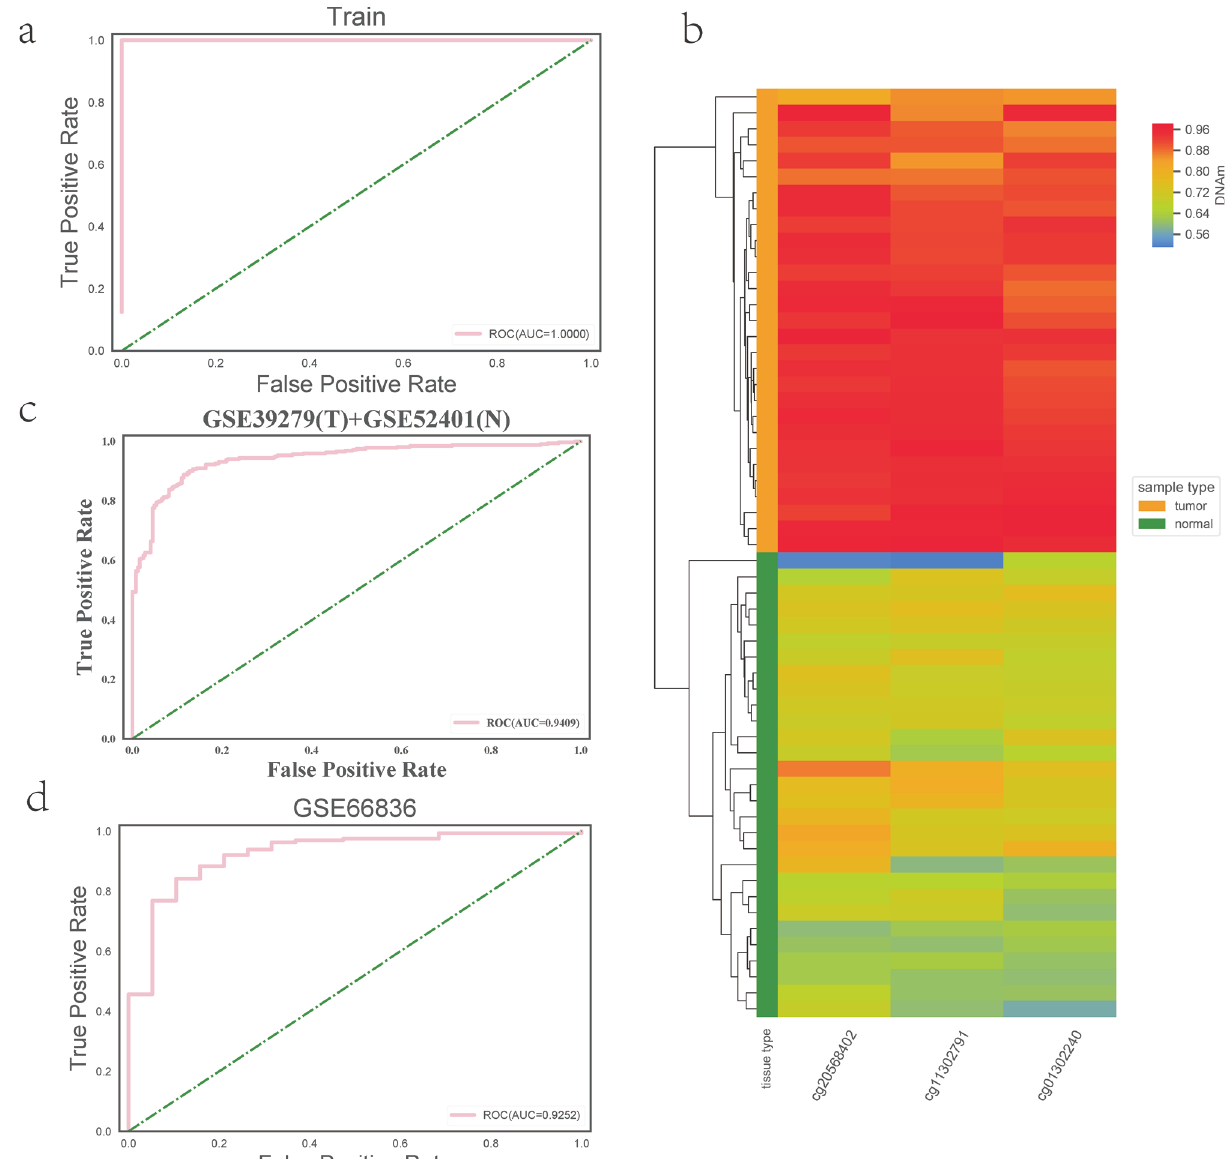
Figure 2 - Screening of methylation markers for lung adenocarcinoma and the construction and validation of the diagnostic classifier. (a) The ROC curve of the logistic regression model. (b) Unsupervised clustering map of the methylation profile for the three DNA methylation markers. (c, d) ROC curves in the independent validation